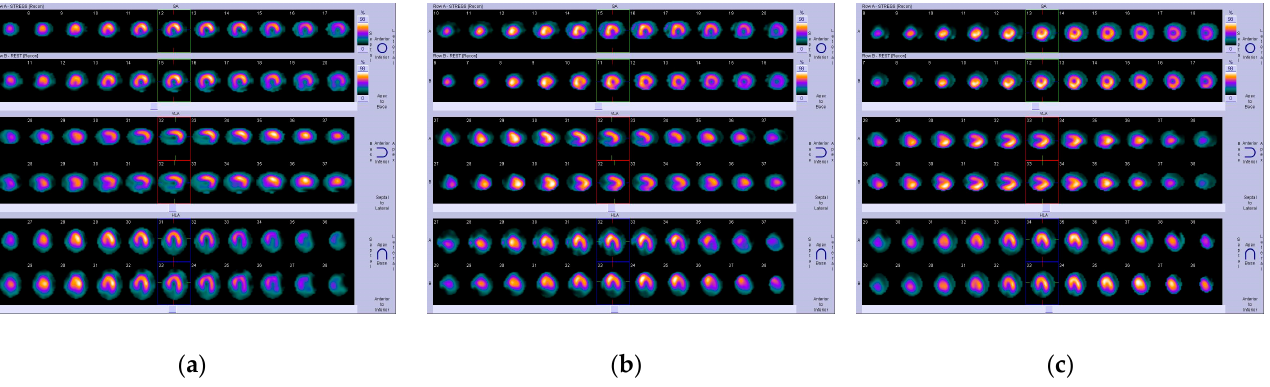
Figure 1. Image samples of coronary artery disease: ( a ) Infarction; ( b ) ischemia; ( c ) normal. The clinical characteristics of the dataset are presented in Table 1. Table 1. Clinical characteristics of the corresponding dataset.